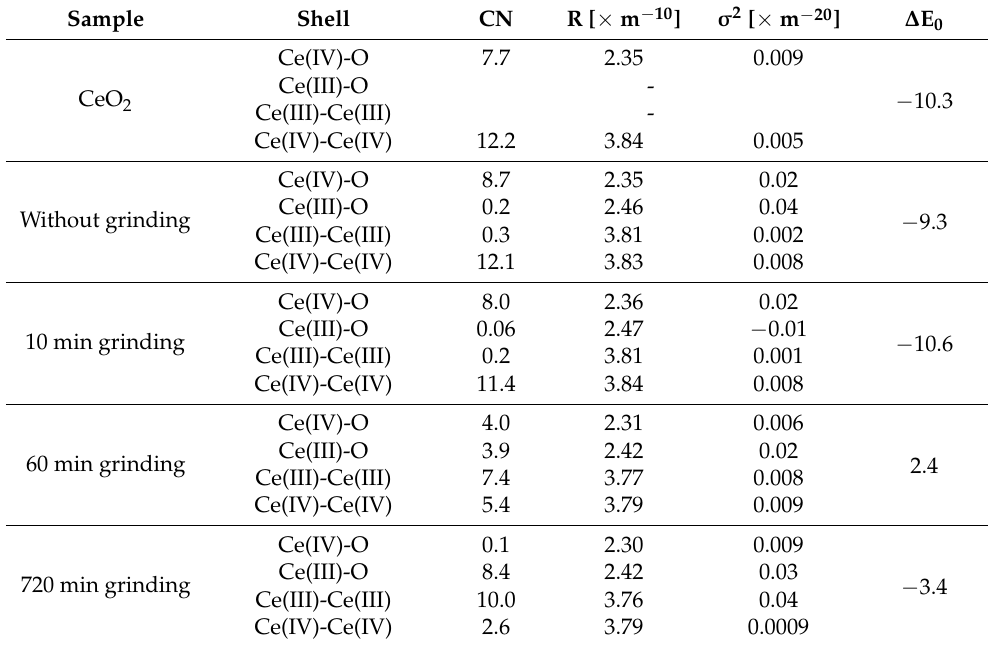
Table 5. Cerium fitting results of the radial distribution function for samples without and with grinding, assuming four kinds of cerium shells for tetravalent cerium oxide